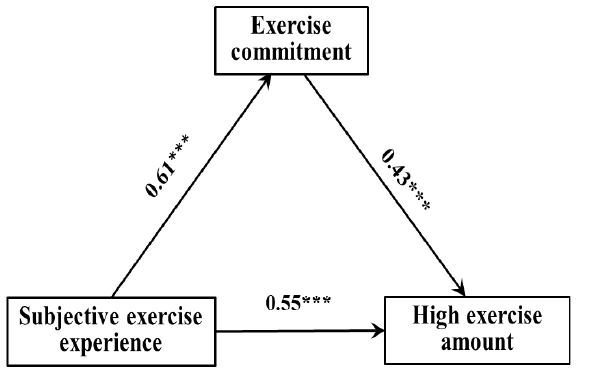
Figure 4. The path model of exercise commitment between subjective exercise experience and high exercise amount. *** p < 0.001. exercise amount. *** p <